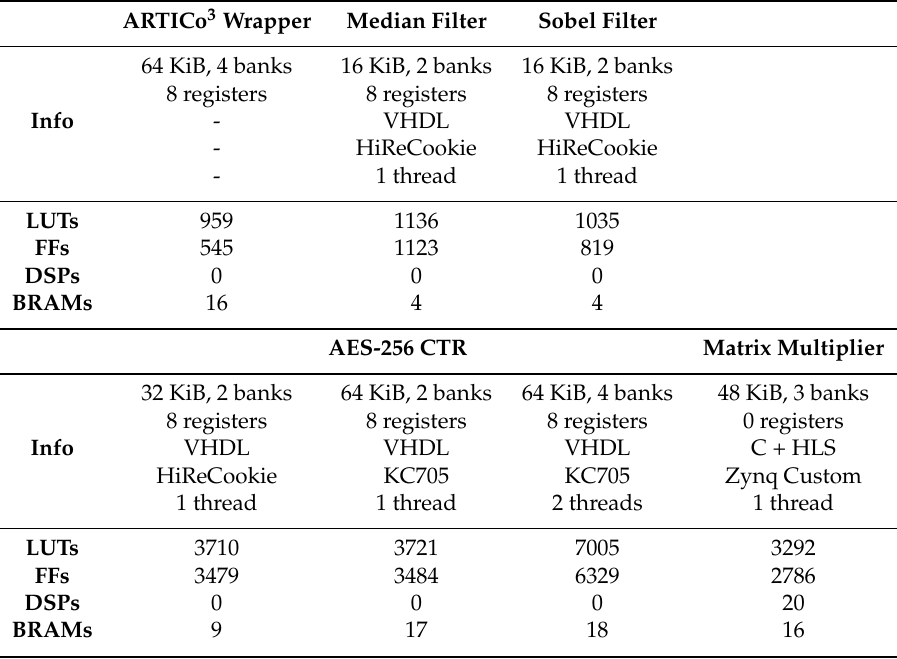
Table 4. Resource utilization: ARTICo 3